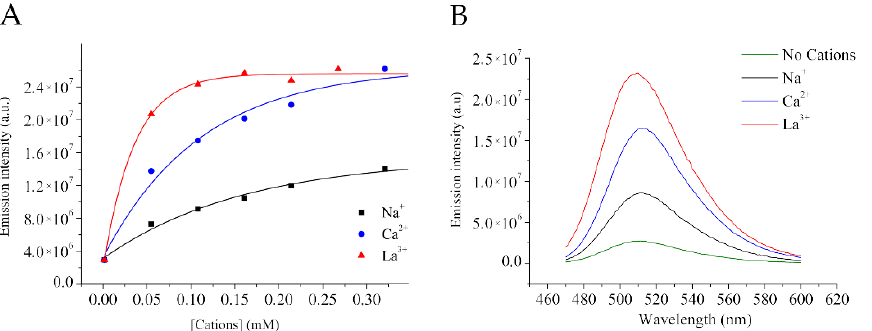
Figure 2. ( A ) Emission intensity increases by increasing cations concentration. ( B ) Comparison of emission spectra for 0.1 mM of cations and 10 µM HPTS. (pH = 6.2 ± 0.1). As it is possible to extract from the curves, when 10 µM HPTS are placed in the presence of 0.1 mM of cations, there is an enhancement of ca. 200% (for Na + ), ca. 500% (for Ca 2+ ), and ca. 730% (for La 3+ ) (Figure 2A). The parameters of the exponential fittings represented in Figure 2A are available as Table S3.